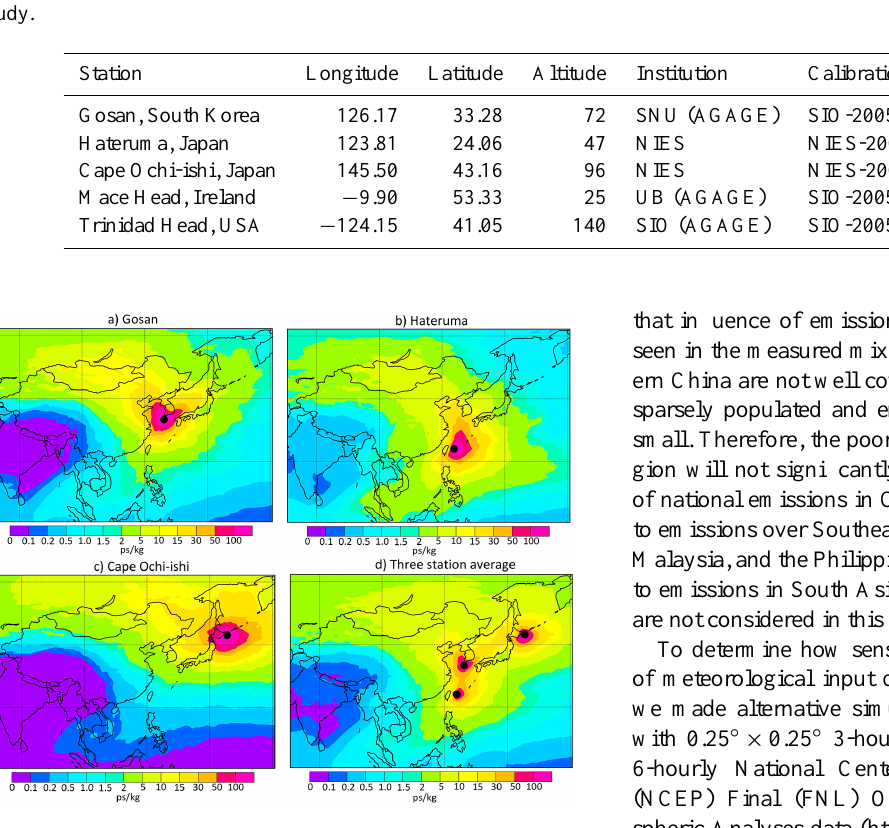
Fig. 1. Footprint emission sensitivity obtained from FLEXPART 20-day backward simulations based on ECMWF input data aver- aged for the period 2006–2012 for Gosan (a) , Hateruma (b) , Cape Ochi-shi (c) and all three stations (d) . Black dots represent the cor- responding measurement